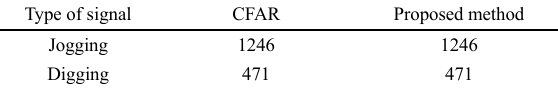
Table 6: Number of alarms in intrusion